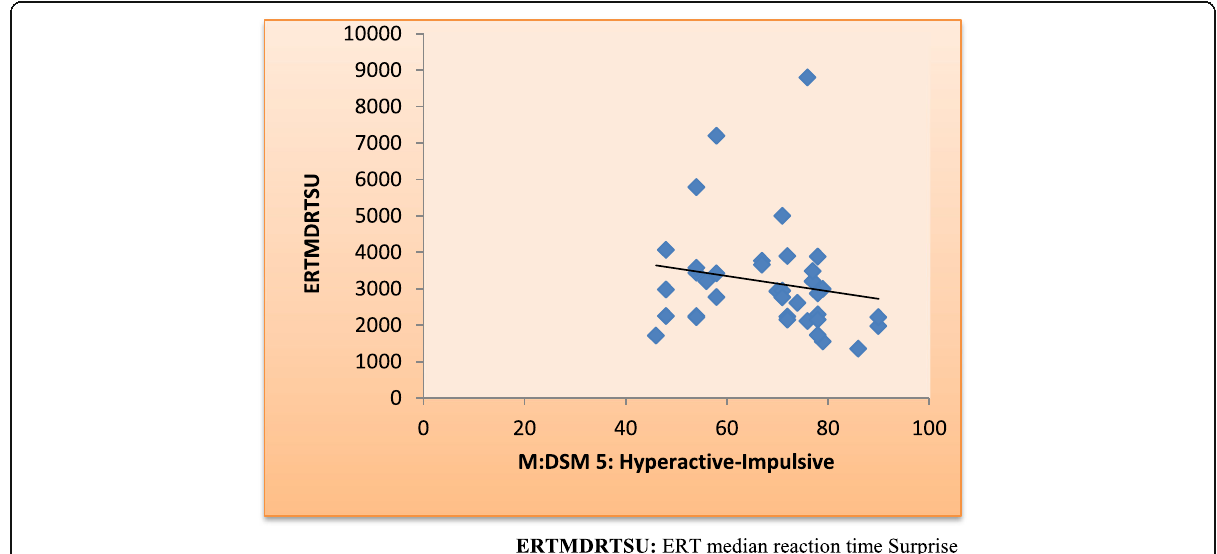
Fig. 1 Scatter chart showing negative correlation between ERTMDRTSU and ADHD hyperactive impulsive